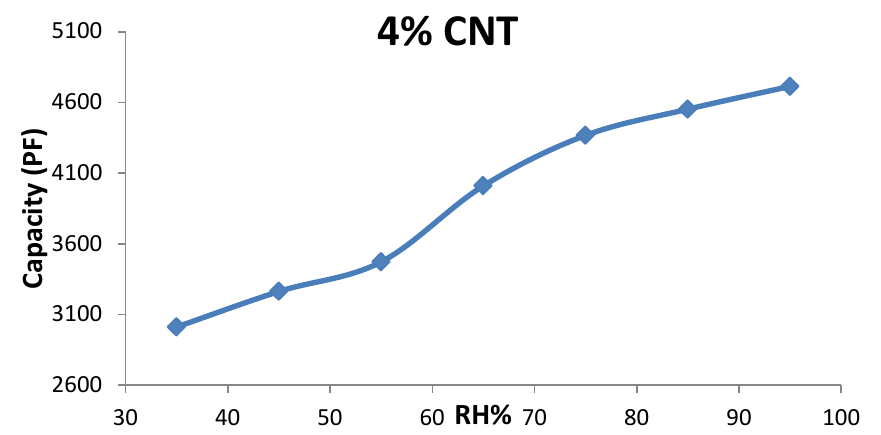
Fig.7: Humidity capacitance relationship for humidity sensors with 4%